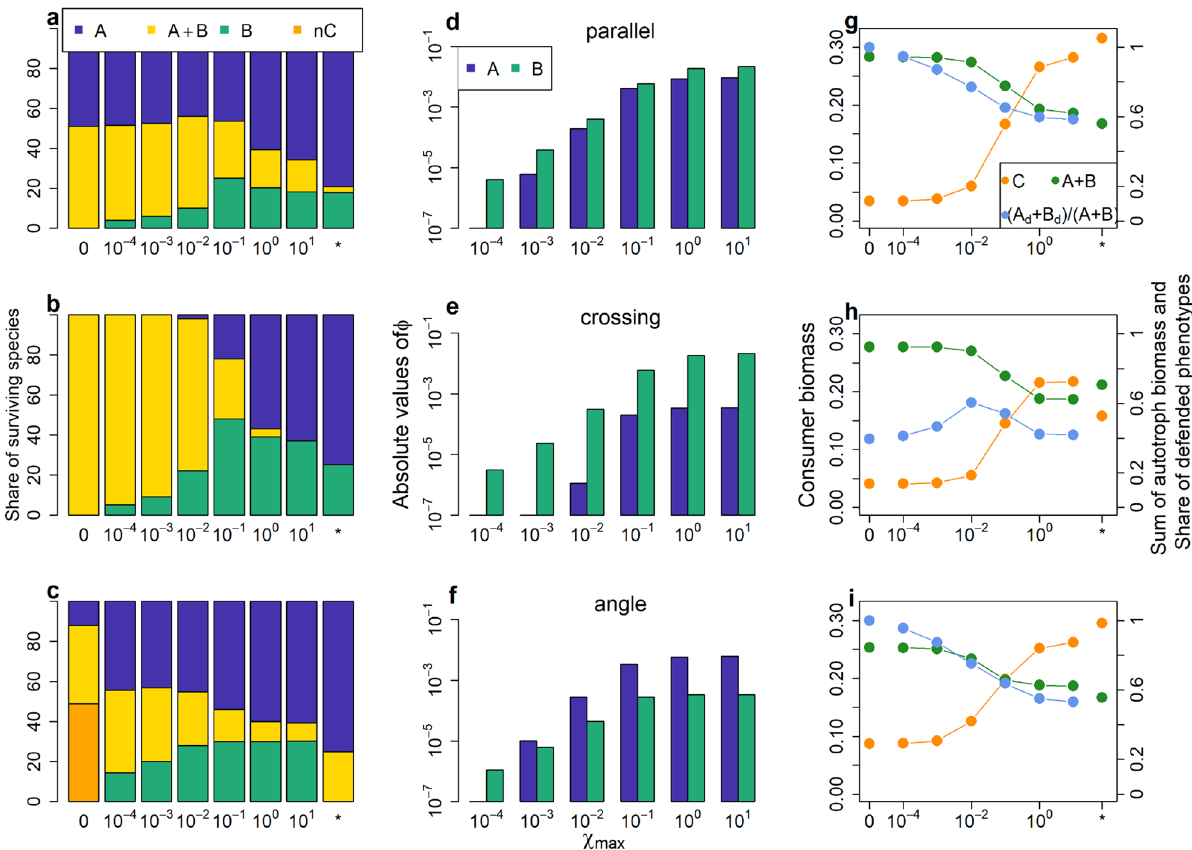
Figure 6. General patterns for coexistence, maladapative switching and biomasses. Share of surviving species in percent ( A , B , coexistence or neutral coexistence) ( a – c ), median absolute value of maladaptive switching Φ ( d – f ) and median of total autotroph biomass ( A + B ), median consumer biomass C and share of defended phenotypes (( A d + B d )/( A + B )) ( g – i ) for the three constellations and increasing maximum exchange rates χ max . χ max = 0 denotes the non-plastic scenarios; *denotes the rigid scenarios. Maladaptive switching and the share of defended phenotypes do not apply for the rigid (Fig. 5b,f). As in the other constellations, the area of coexistence and the biomasses of the defended phenotypes decreased and antiphase cycles vanished with increasing χ max (Fig. 5b,f, Supplementary Figure S8), while mala- daptive switching and the consumer biomass increased (Fig. 5).